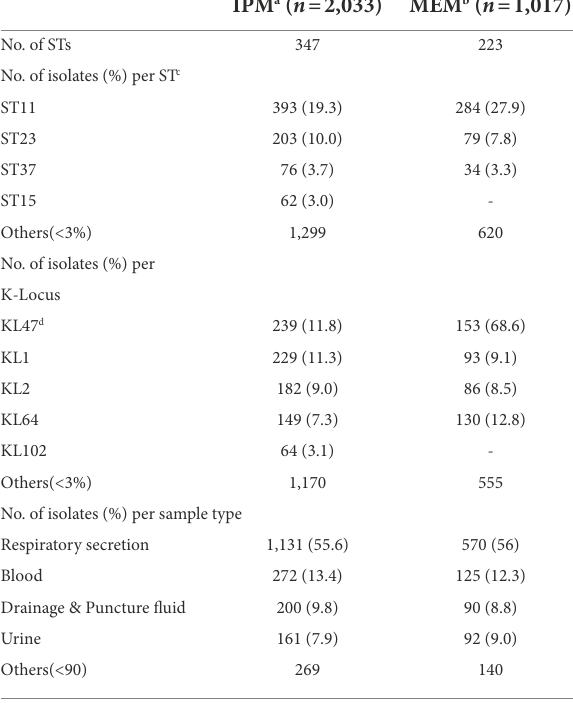
TABLE 1 Diversity and MLST information of the two